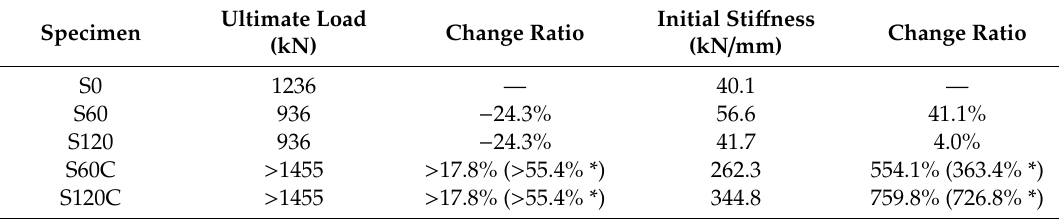
Table 4. Ultimate loads ( F v, max ) and initial sti ff